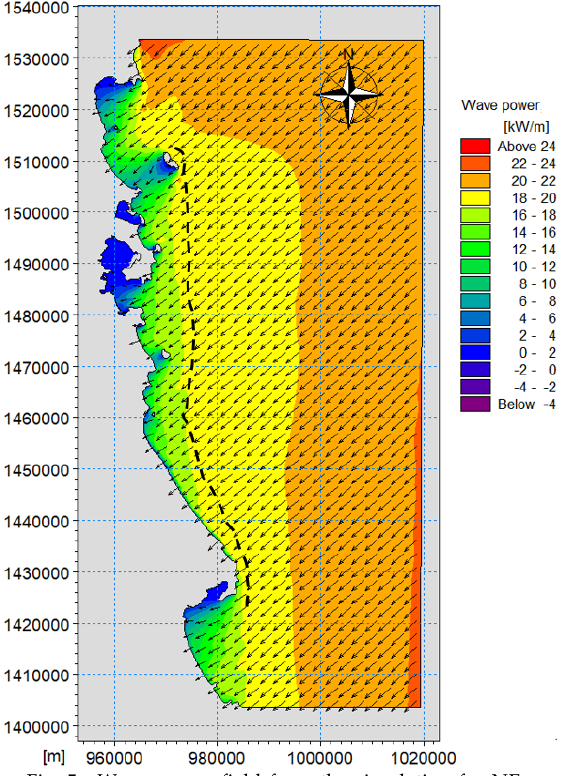
Fig. 5. Wave power field from the simulation for NE waves in January. The 30-m depth contour segment is also shown as a dashed